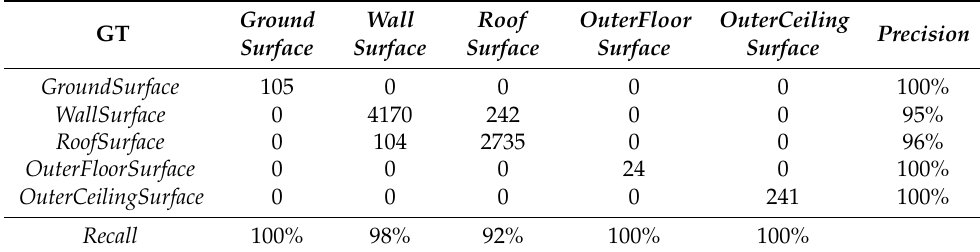
Table 5. Quantitative evaluation of building surface classification..